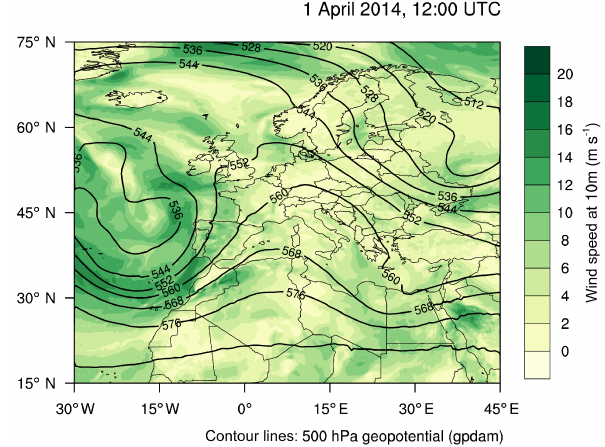
Figure 3. Large-scale synoptic situation on 1 April 2014, 12:00UTC. Contour lines show the 500hPa geopotential field, and the wind speed at 10m is depicted by colored shading. The fields are retrieved from a global + 12h ICON-ART forecast with an ef- fective grid spacing of